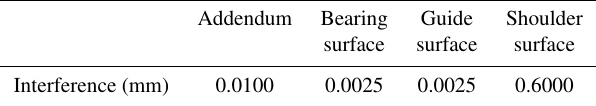
Table 2. Interferences of contact